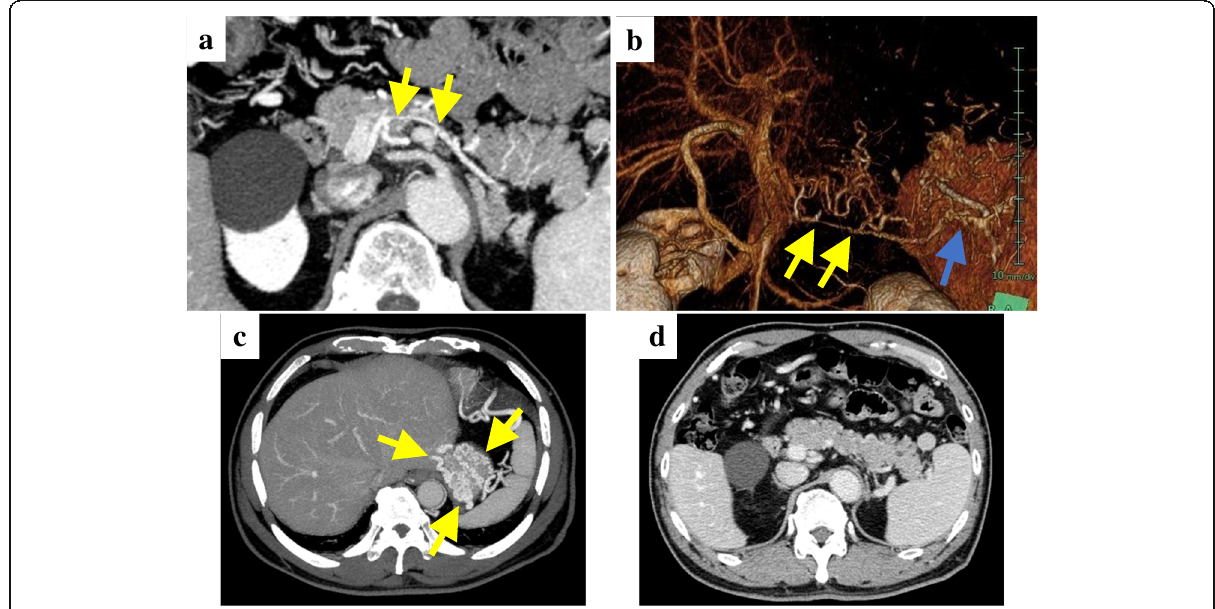
Fig. 2 Contrast-enhanced abdominal computed tomography findings. a , b Stenosis (2 mm in diameter, yellow arrows) of almost the entire length of the splenic vein, with post-stenosis dilatation at the splenic hilum (10 mm in diameter, blue arrows). c Development of gastric fundal varices and short gastric veins. d No inflammatory changes around the pancreas or pancreatic neoplasm were observed. a , c , d Axial views.